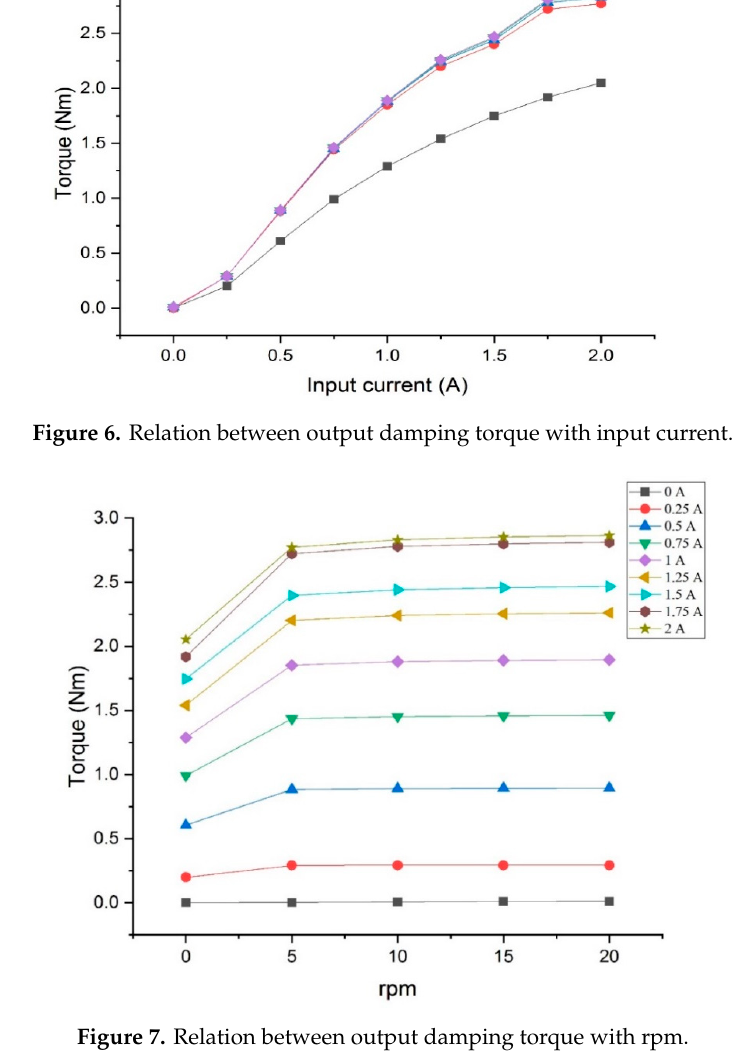
Figure 7. Relation between output damping torque with rpm.